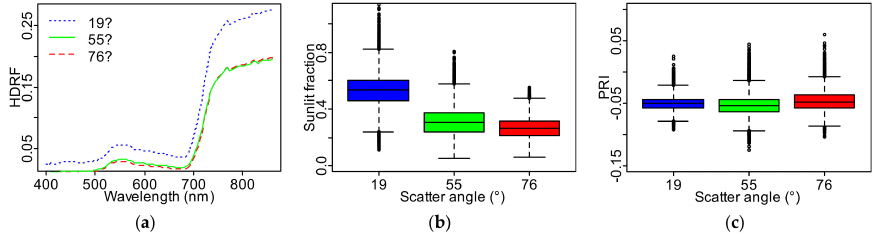
Figure 3. Average Scots pine top of canopy (TOC) spectral reflectance ( a ), Scots pine canopy sunlit fraction ( b ) and Scots pine canopy photochemical reflectance index (PRI) ( c ) for three scatter angles ( β = 19 ◦ , 55 ◦ and 76 ◦ ).